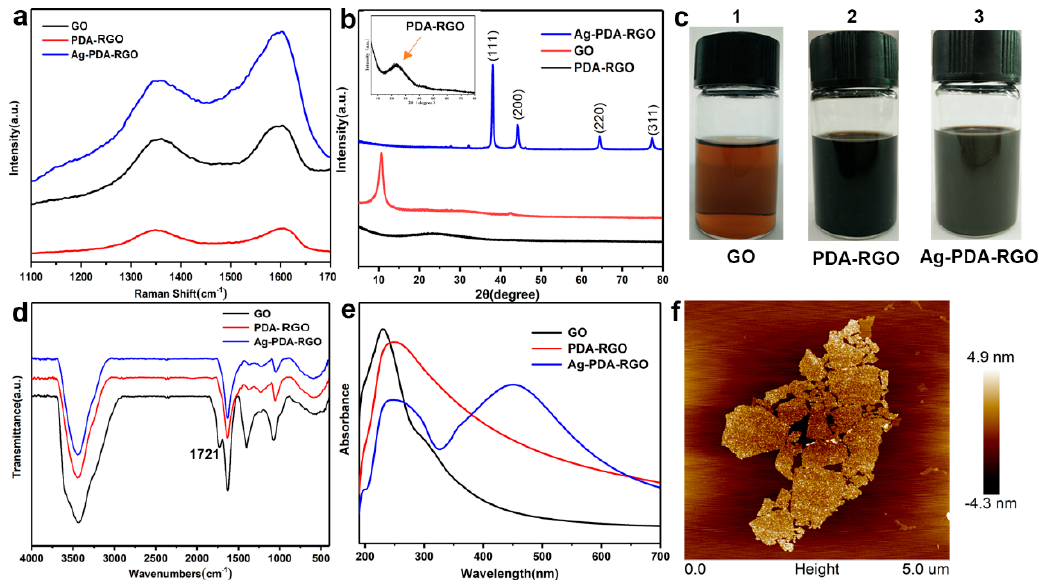
Figure 3. Raman spectra ( a ), XRD pattern ( b ) of GO, PDA-RGO, and Ag-PDA-RGO, and the optical picture ( c ) of GO (1), PDA-RGO (2), and Ag-PDA-RGO (3) aqueous solution. FTIR spectra ( d ), UV–visible spectra ( e ) of GO, PDA-RGO, and Ag-PDA-RGO. Atomic force microscopy (AFM) image ( f ) of